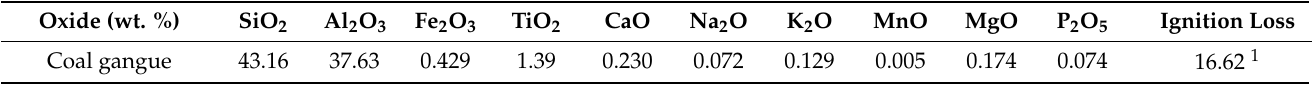
Table 1. Chemical composition (wt. %) of raw kaolinite-rich coal gangue (RCG). Oxide (wt. %) SiO 2 Coal gangue 43.16